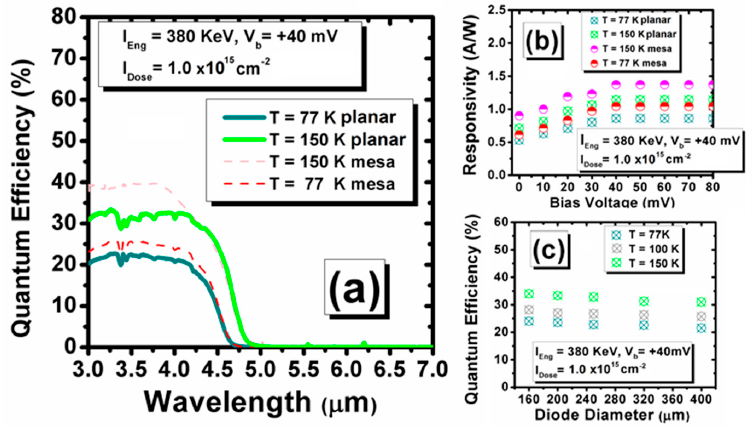
Figure 4. ( a ) Saturated 77 K and 150 K quantum efficiency (QE) spectra of the 200 µm diameter optimized planar device compared to a reference mesa-isolated device. The 100% cut-off wavelength is 4.6 µm at 77 K and increases to 4.9 µm at 150 K; ( b ) responsivity vs. bias voltage showing saturation at +40 mV; and ( c ) QE vs. diameter showing no size dependence.